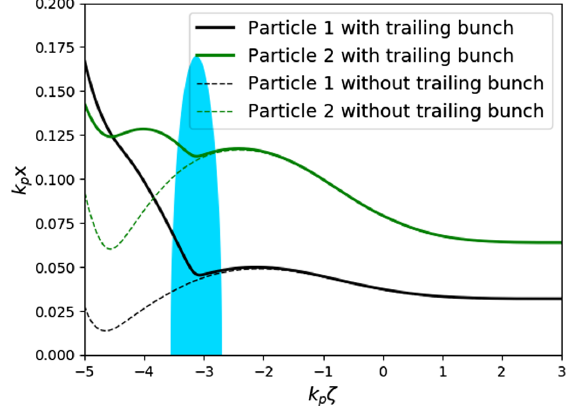
FIG. 5. A detail of the trajectories (continuous lines) of two sample particles crossing the witness (blue). To remark the witness effect also the trajectories of the same particles without witness (dashed lines) are displayed.